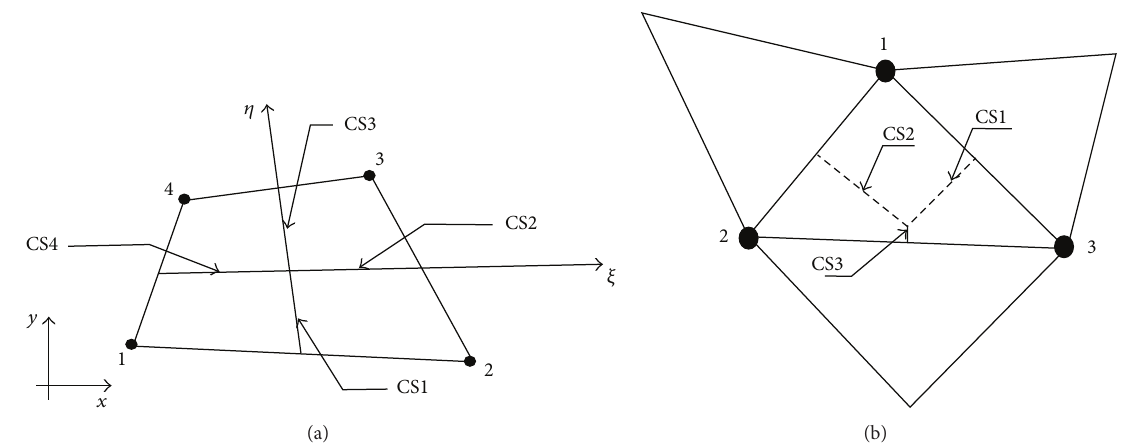
Figure 1: Element and integration points on control surfaces: (a) quadrilateral element and (b) tetrahedral element.